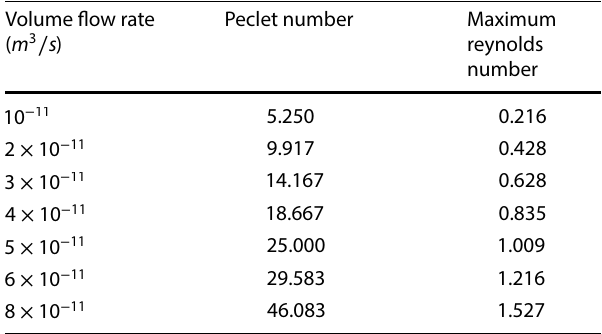
Table 2 Peclet number and maximum reynolds number in different flow